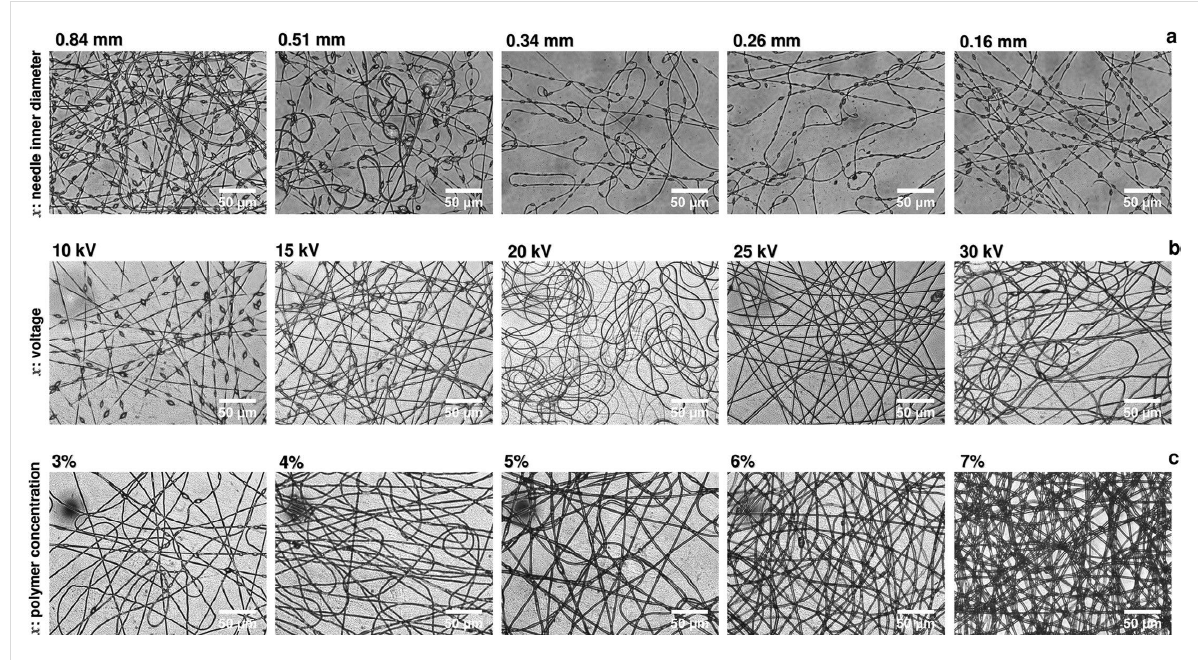
Figure 2: Optical microscopy images of PHB/HAp fibers electrospun under different processing conditions. (a) Polymer concentration of 4%, voltage of 15 kV, inner needle diameter of 0.16–0.84 mm; (b) polymer concentration of 4%, voltage of 10–30 kV, inner needle diameter of 0.34 mm; and (c) polymer concentration of 3–7%, voltage of 25 kV, inner needle diameter of 0.34 mm. Figure 2 was reprinted from [31], Journal of Material Science & Technology, vol. 32, by M. Sadat-Shojai, “Electrospun polyhydroxybutyrate/hydroxyapatite nanohybrids: microstructure and bone